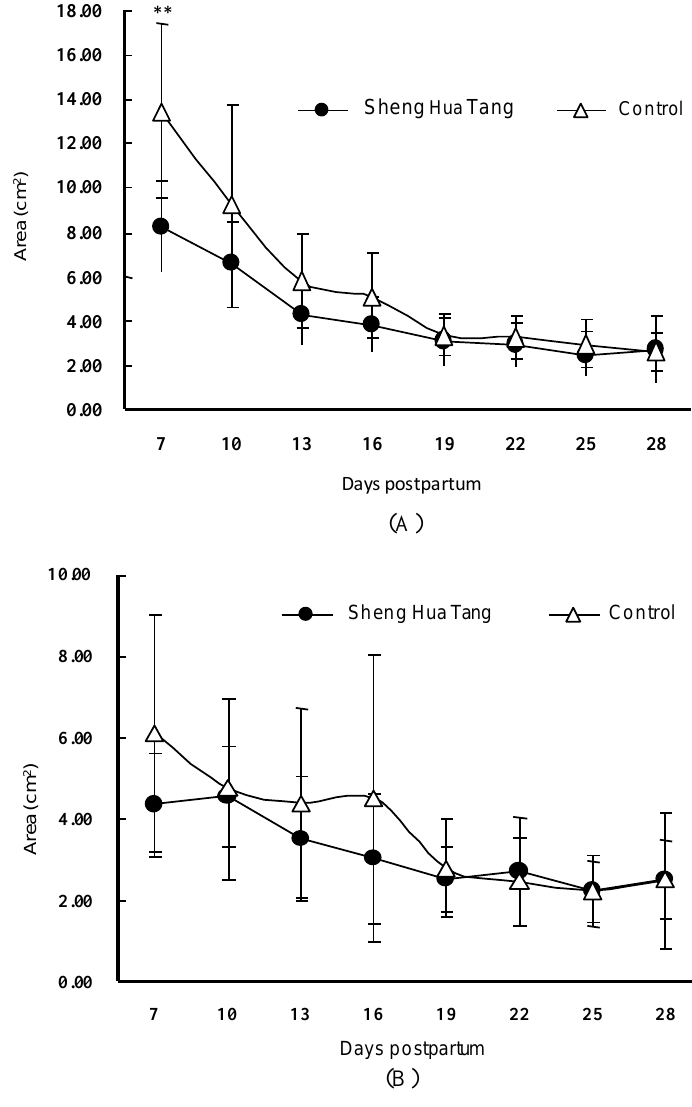
Figure 2. Effects of Sheng Hua Tang treatment on involutionary progress curves for endometrial areas of uterine horn in postpartum dairy cows. Means  SE (n = 10). (A) The endometrial area of gravid uterine horn was obviously reduced in the Sheng Hua Tang- receiving group than the control group on the 7th d postpartum. ** Means differ significantly between groups (p<0.01); (B) The endometrial area of nongravid uterine horn, there were no significant differences in both experimental and control